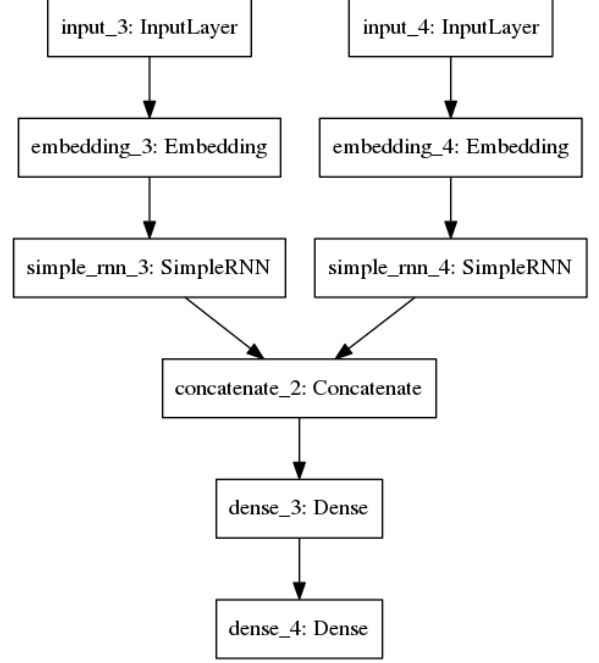
Figure 5. The multi-input RNN architecture with string inputs that undergo embedding.